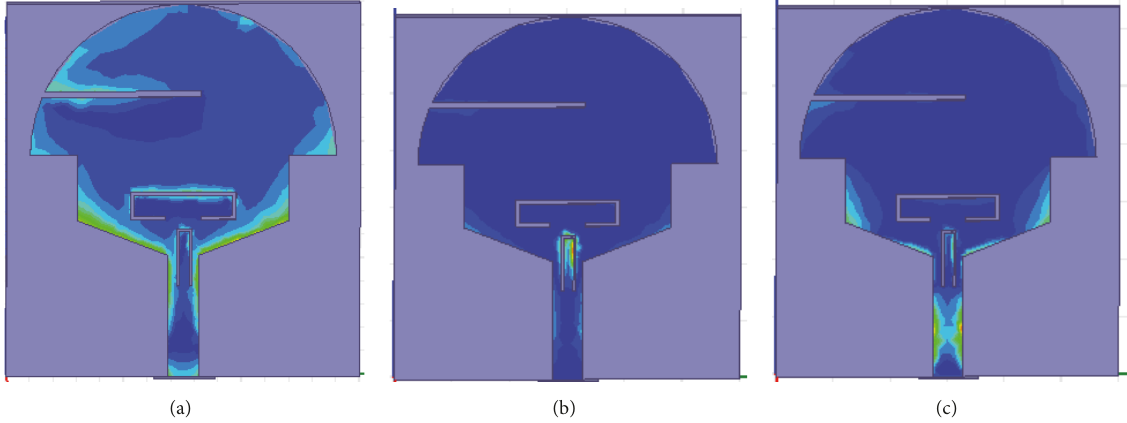
Figure 11: Surface current of the UWB antenna (a) 4 GHz, (b) 7 GHz, and (c) 9GHz.